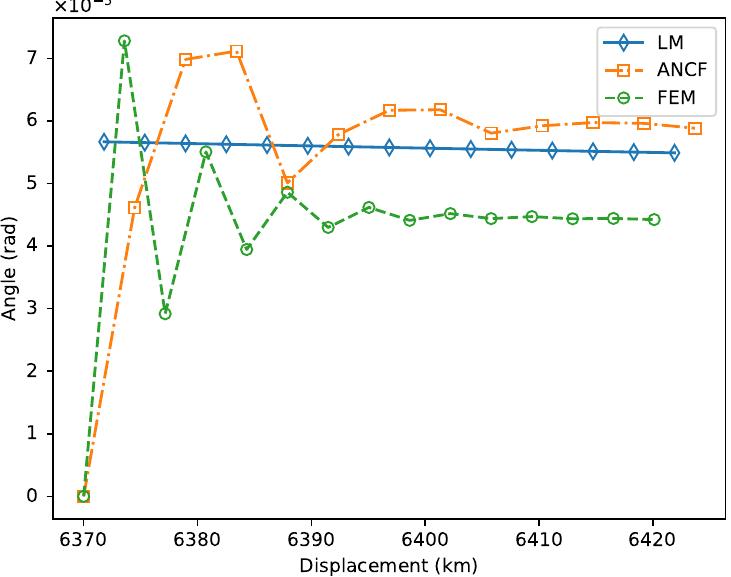
Figure 10. Nodal angle θ close to the ground. Similarly, when the Y -axis loading turns to the Z -axis, the resulting deformation curve is shown in Figure 11. Since the centrifugal force has no contribution to the coordinates in the Z direction, the deformation of the Z axis is much smaller than that of the Y axis, and the results calculated by each method are closer.